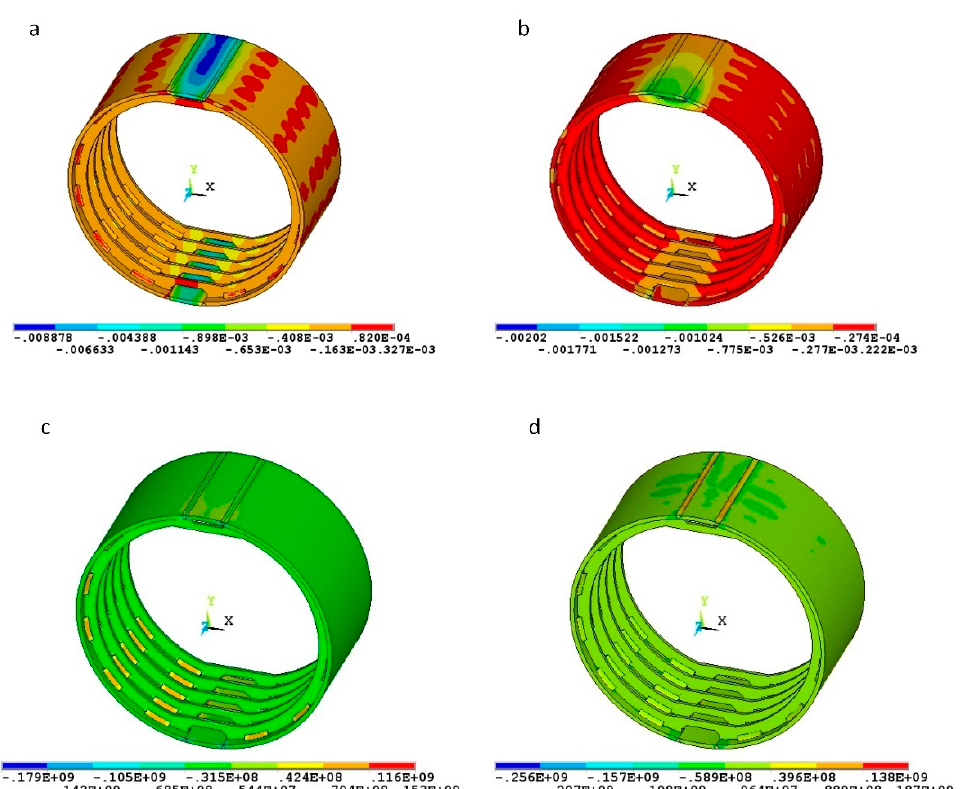
Figure 10. Residual distortion and stress of the 5A06 aluminum alloy cylinder. ( a ) Radial distortion (m). ( b ) Axial distortion (m). ( c ) Radial residual stress (MPa). ( d ) Axial residual stress (MPa).